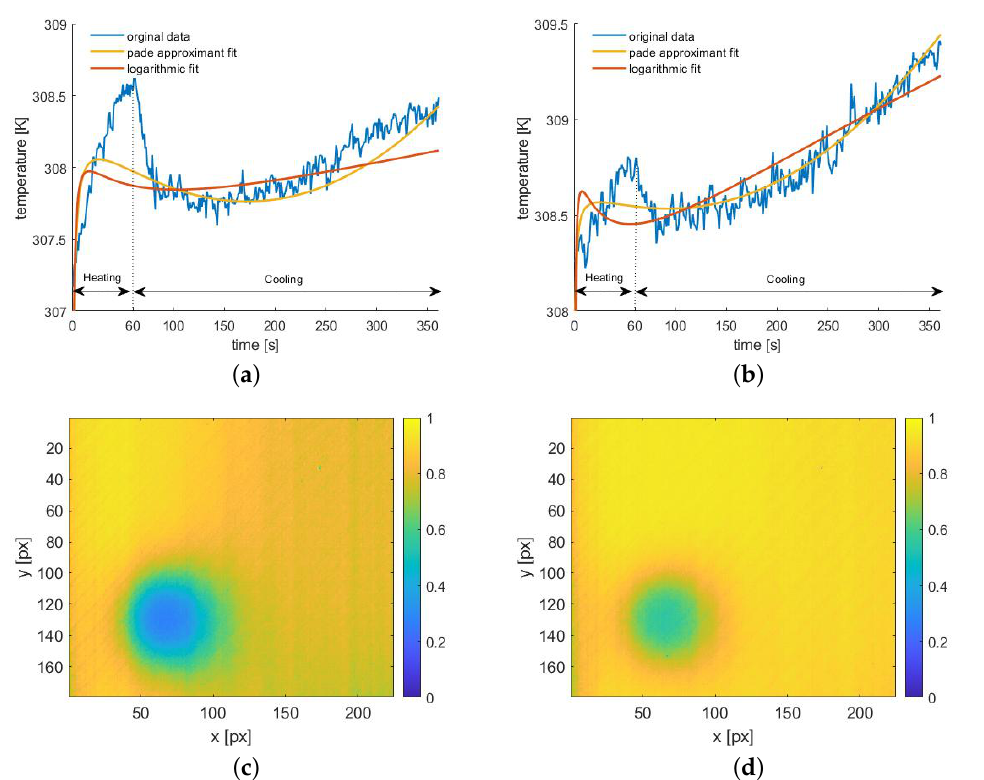
Figure 4. The results of the curve-fitting approach obtained for exemplary defect (having φ of 4 mm and D of 18 mm): comparison of the fitting curves obtained using orthogonal logarithmic functions (red line) a Pad´e approximants (yellow line) for defect ( a ) and sound ( b ) areas; map of the correlation coefficient value obtained for the orthogonal logarithmic functions fit ( c ) and Pad´e approximants ( d